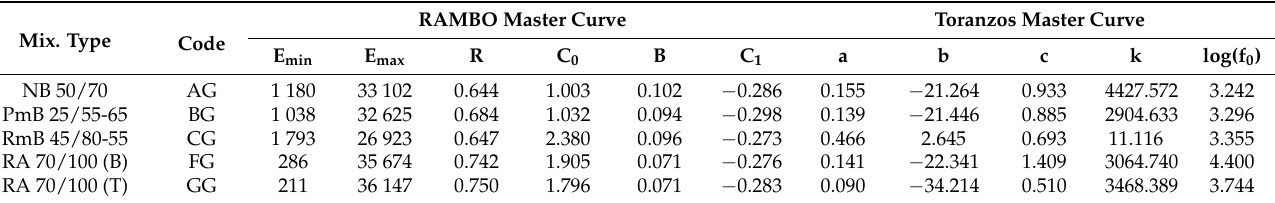
Table 4. Average model parameters of master curves.